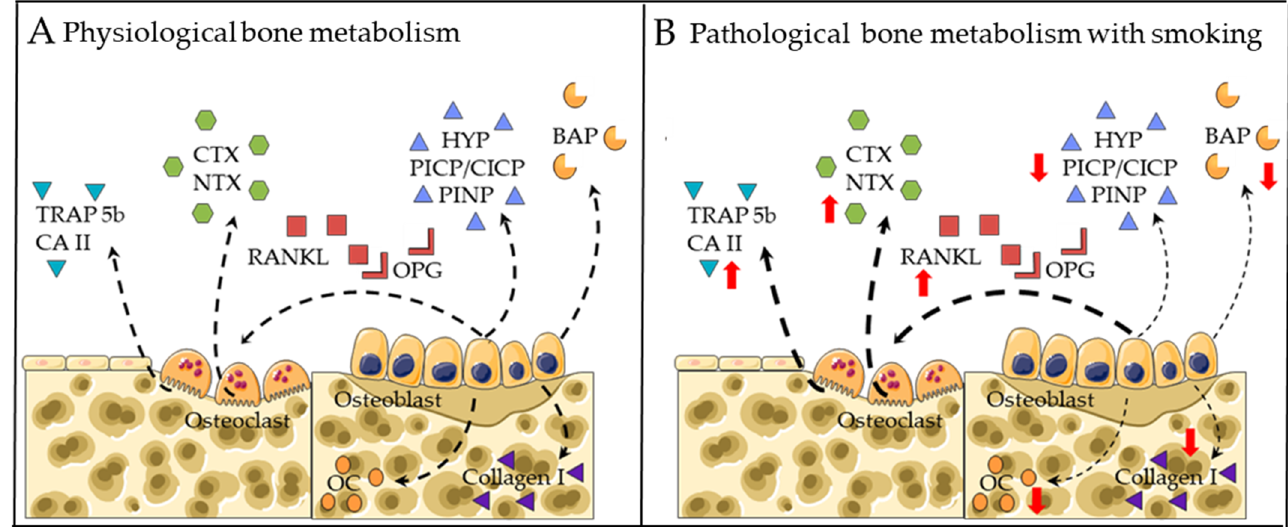
Figure 1. Established gene markers for bone metabolism in ( A ) physiological conditions and ( B ) CS exposure conditions. Bone resorption markers include: tartrate-resistant acid phosphatase isoform 5b (TRAP5b), carbonic anhydrate II (CA II), C-terminal telopeptide (CTX) and N-terminal telopeptide (NTX). Regulators of osteoclastogenesis include: receptor activator of nuclear factor kappa B ligand (RANKL) and osteoprotegerin (OPG). Bone formation markers include: osteocalcin (OC), collagen I, bone-specific alkaline phosphatase (BAP), hydroxyproline (HYP) and type I collagen N- and C-terminal propeptides (PINP and PICP/CICP). Dotted arrows represent expression. Red arrows represent altered expression (up or down).